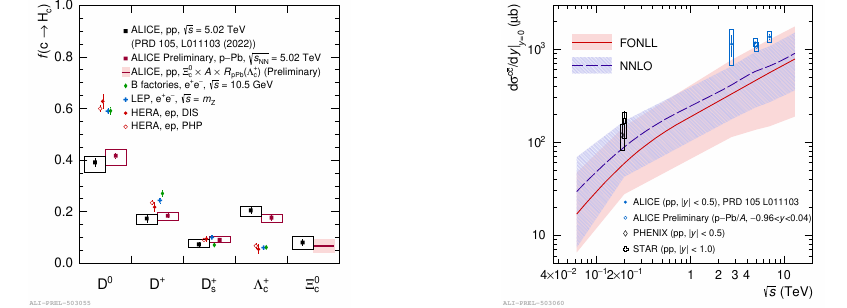
Figure 3. Left panel: Charm-quark fragmentation fractions into charm hadrons in pp and p–Pb colli- sions at √ s = 5.02TeV . Right panel: charm production cross section at midrapidity as a function of the collision